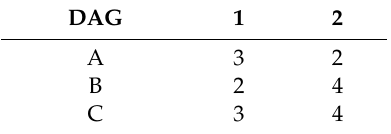
Table 5. Start time ( ST ki ) for each DAG.